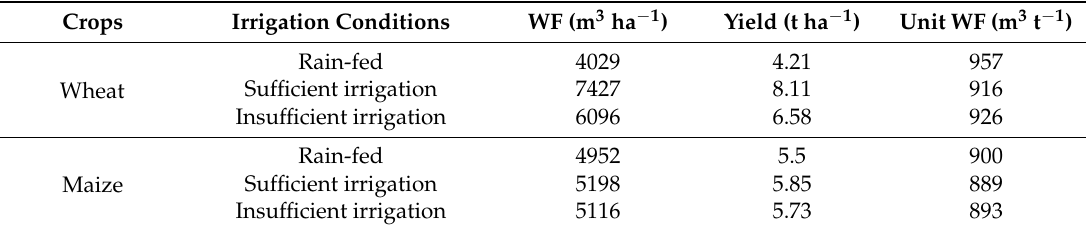
Table 6. Comparison of WF under different irrigation conditions,